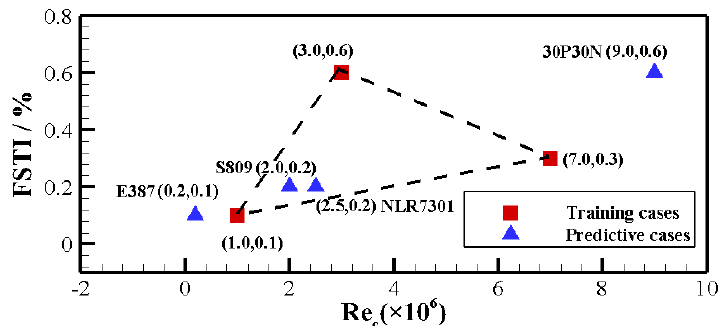
Figure 9. Training and predicting example settings.